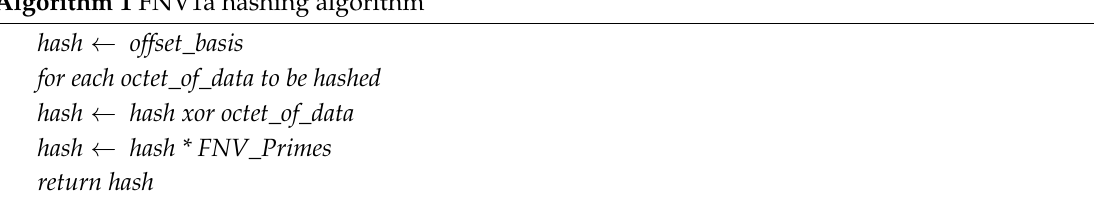
Algorithm 1 FNV1a hashing